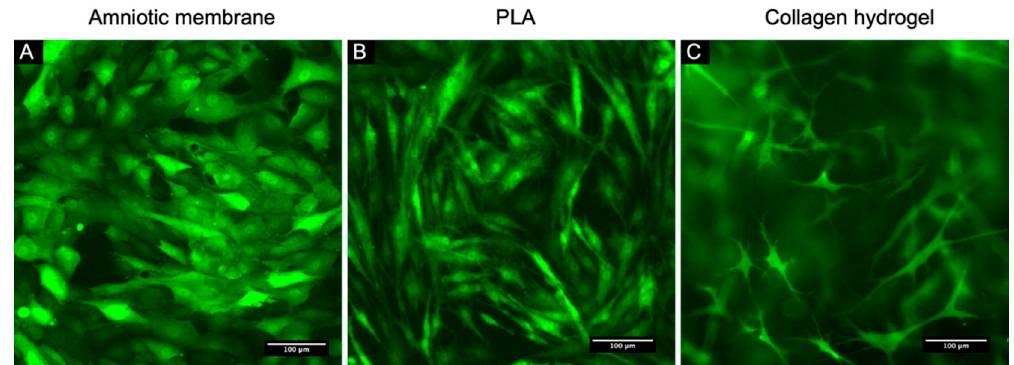
Figure 7. Live-cell fluorescence microscopy of L-MSCs-EGFP on different scaffolds after 7 days of cultivation. ( A ). L-MSCs- EGFP on decellularized AM. ( B ). L-MSCs-EGFP on PLA scaffold. ( C ). L-MSCs-EGFP on collagen hydrogel. Scale bars: ( A – C ) 100 micrometers ( μ m).